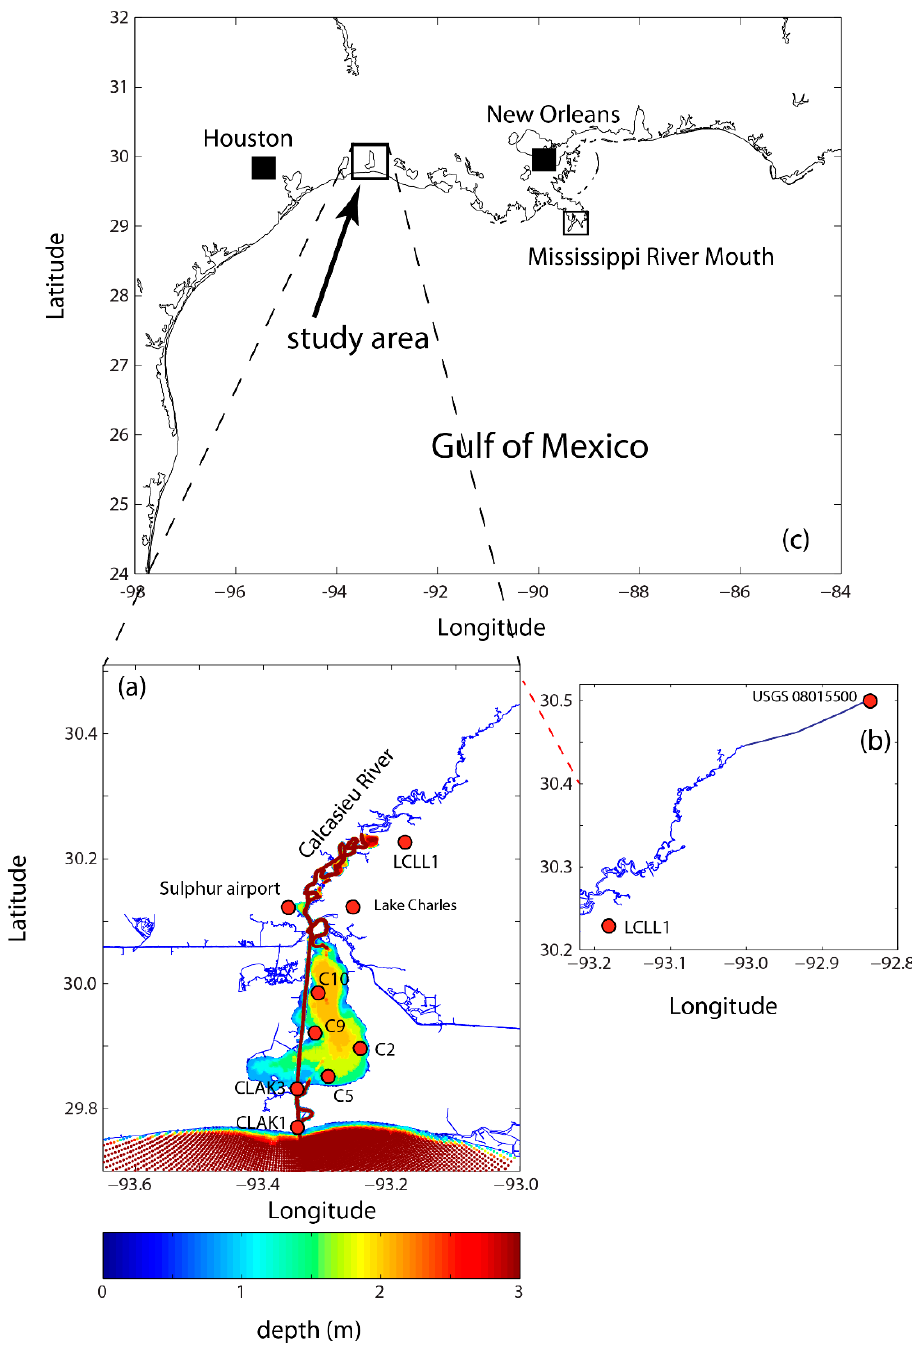
Figure 1. Study area and stations for instruments. ( a ) The Calcasieu Lake Estuary and the mean water depth, color coded in meters; ( b ) Extension of the northeast corner of (a); ( c ) zoomed-out view of the map showing the location of study along the northern Gulf of Mexico. The various stations are indicated by solid circles filled in red, e.g., CLAK1 (USCG Maker), CLAK3 (USCG Tower) in the north inside the Calcasieu Pass, the HOBO deployment sites (C5, C10, C2 and C9), discharge station at USGS 08015500, and the weather stations at Sulphur Airport, LCLL1, and Lake Charles, respectively. CLAK2 is between CLAK1 and CLAK3 but it is not used in this paper and therefore not shown on the map.